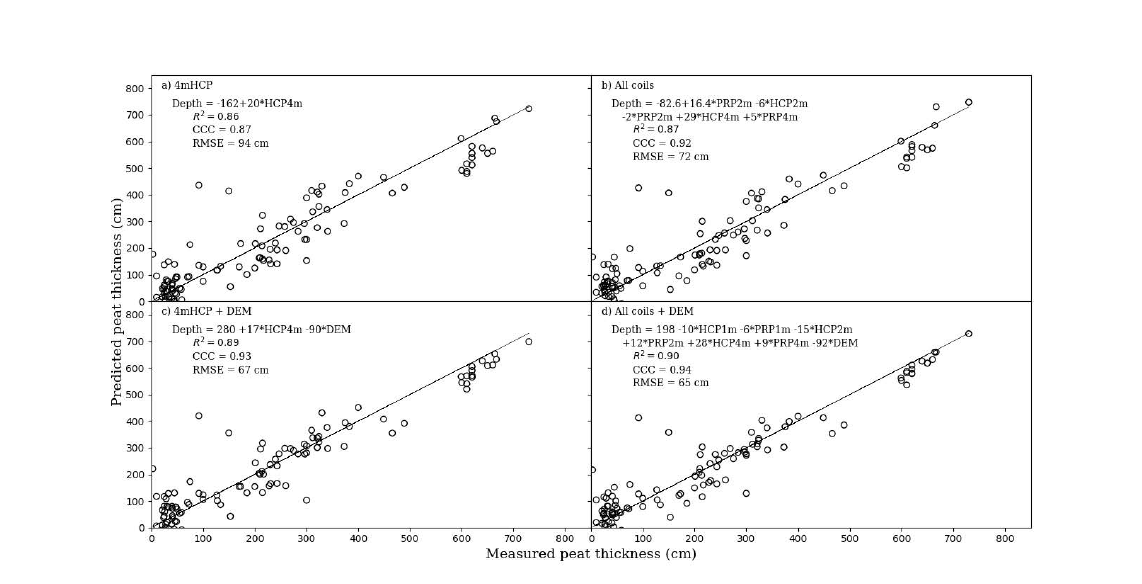
Figure 8. Measured vs. predicted peat thickness (cm) using ( a ) 4mHCP, ( b ) the combination of all six coils, ( c ) the combination of 4mHCP and DEM and ( d ) the combination of all six coils and DEM (1:1 identity line represented on each